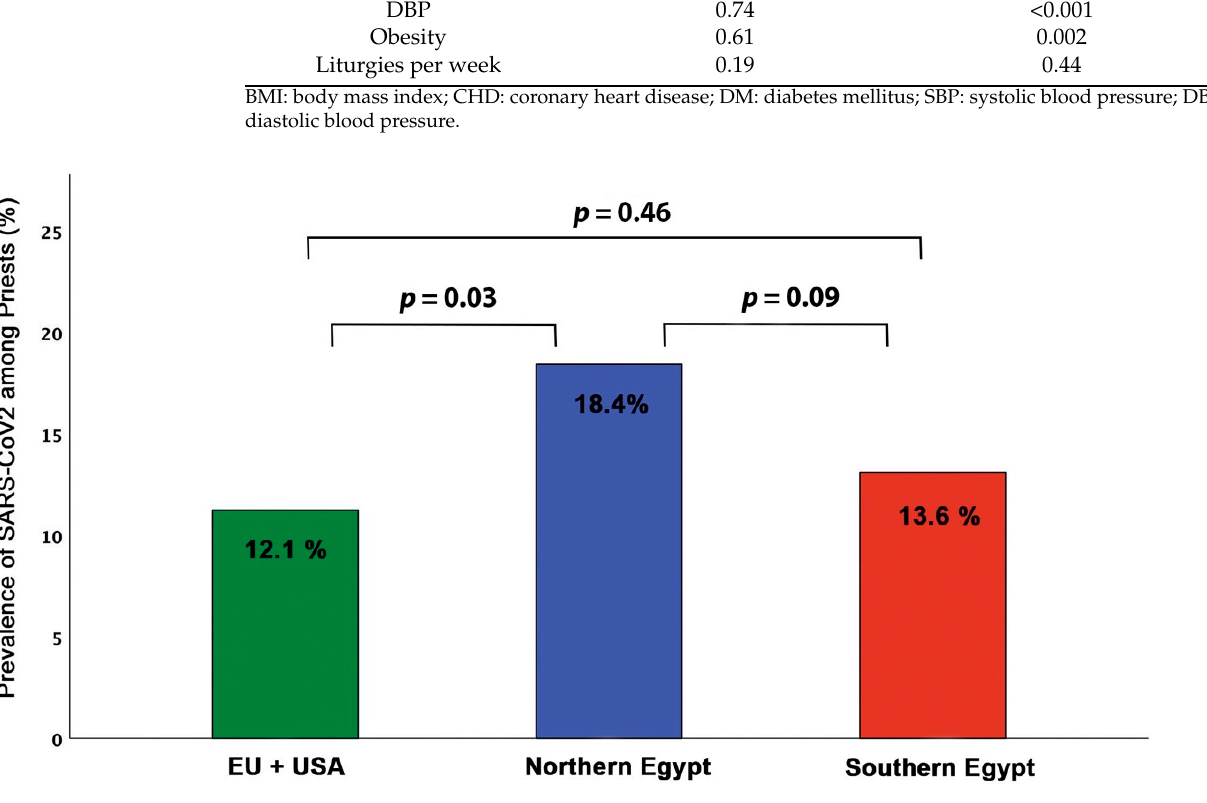
Figure 4. Prevalence of COVID-19 among Clergy in different regions.